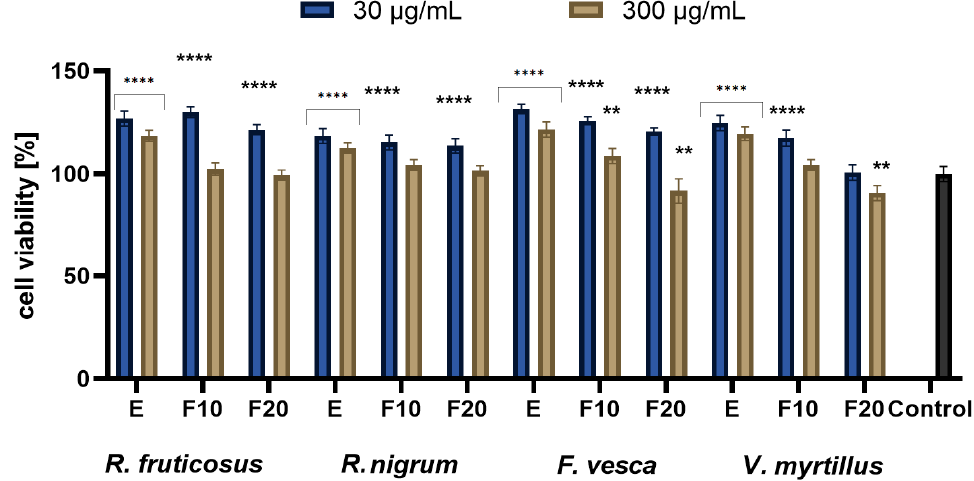
Figure 5. The reduction in resazurin after 24 h exposure to R. fruticosus L., R. nigrum L., F. vesca L., V. myrtillus L. extract and kombucha ferments (at concentrations of 30 and 300 µ g/mL) in cultured keratinocytes (HaCaT). Data are the mean ± SD of three independent experiments, each of which consists of three replicates per treatment group. **** p < 0.0001, ** p < 0.0060 versus the control (100%).